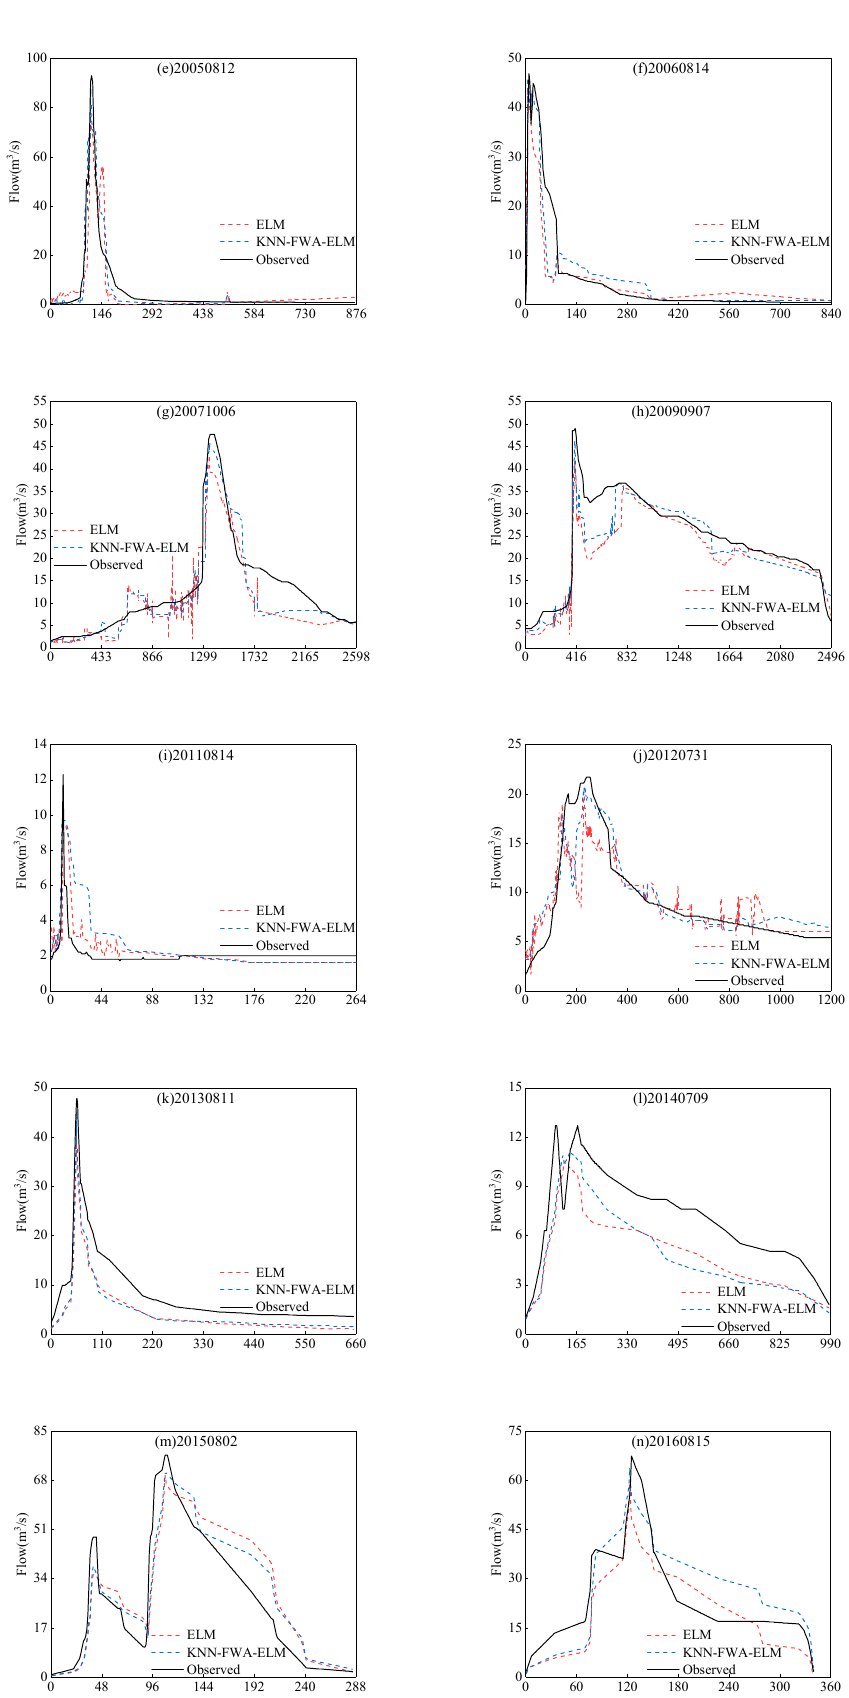
Figure 15. Comparison of KNN-FWA-ELM and ELM simulation